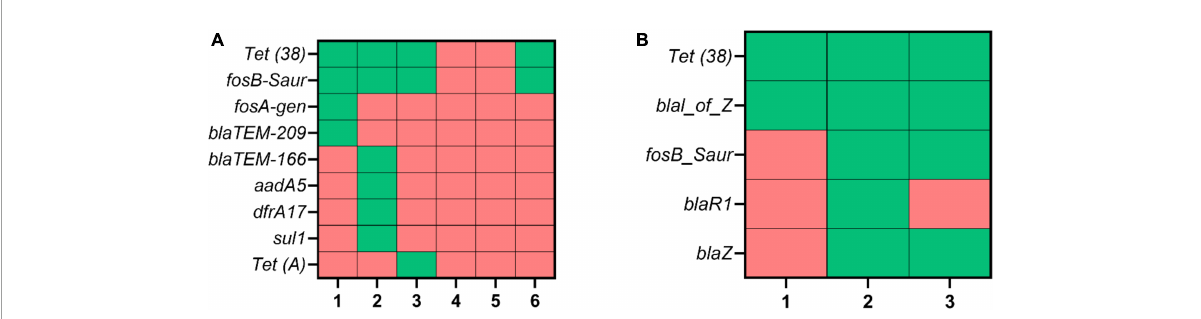
FIGURE4 An overview of identified AMR genes, following MinION DNA sequencing. Two mastitis milk samples (A,B) were subjected to bacterial DNA isolation using different kits and conditions (culture-independent) combinations. The green and red cells show the presence and absence of